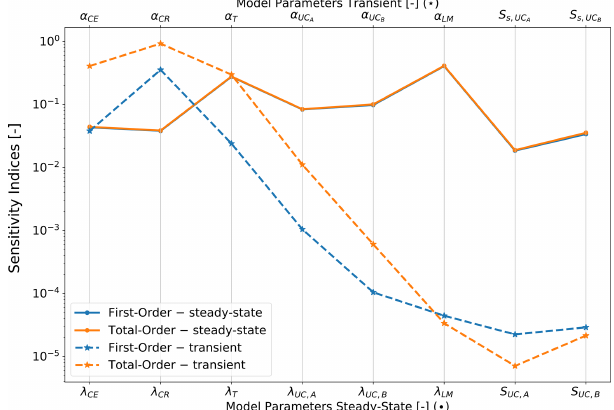
Figure 8. Global sensitivity indices for the analysis with steady- state (solid lines) and transient conditions (dashed lines) of the Cen- tral European Basin System. The first-order indices are denoted in blue and the total-order indices in orange. For the acronyms, please refer to Table A1.